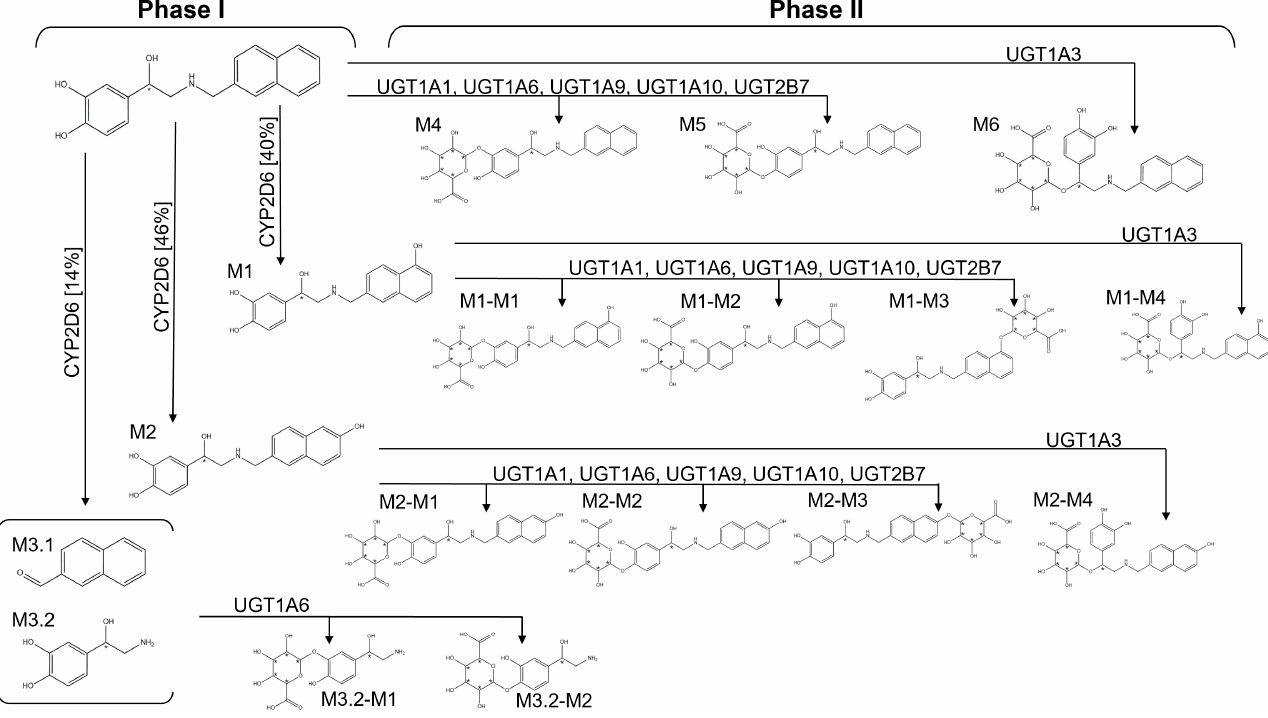
Figure 6. Phase I and phase II metabolism of the SBL-1 compound as predicted by ADMET Predictor™. SBL-1 and its metabolites are displayed as bidimensional chemical structures with their corresponding nomenclature. Each metabolism step is represented by an arrow containing related enzyme(s). The percentage of each metabolite generated during phase I metabolism is shown between brackets. ADMET Predictor™ does not provide the percentage of metabolites generated during phase II. Chiral centers are highlighted by asterisks.